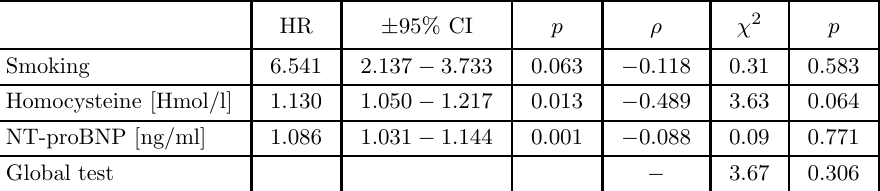
Table 5. Multivariable stepwise backward analysis of Cox proportional hazards regression adjusted for age, statistically significant